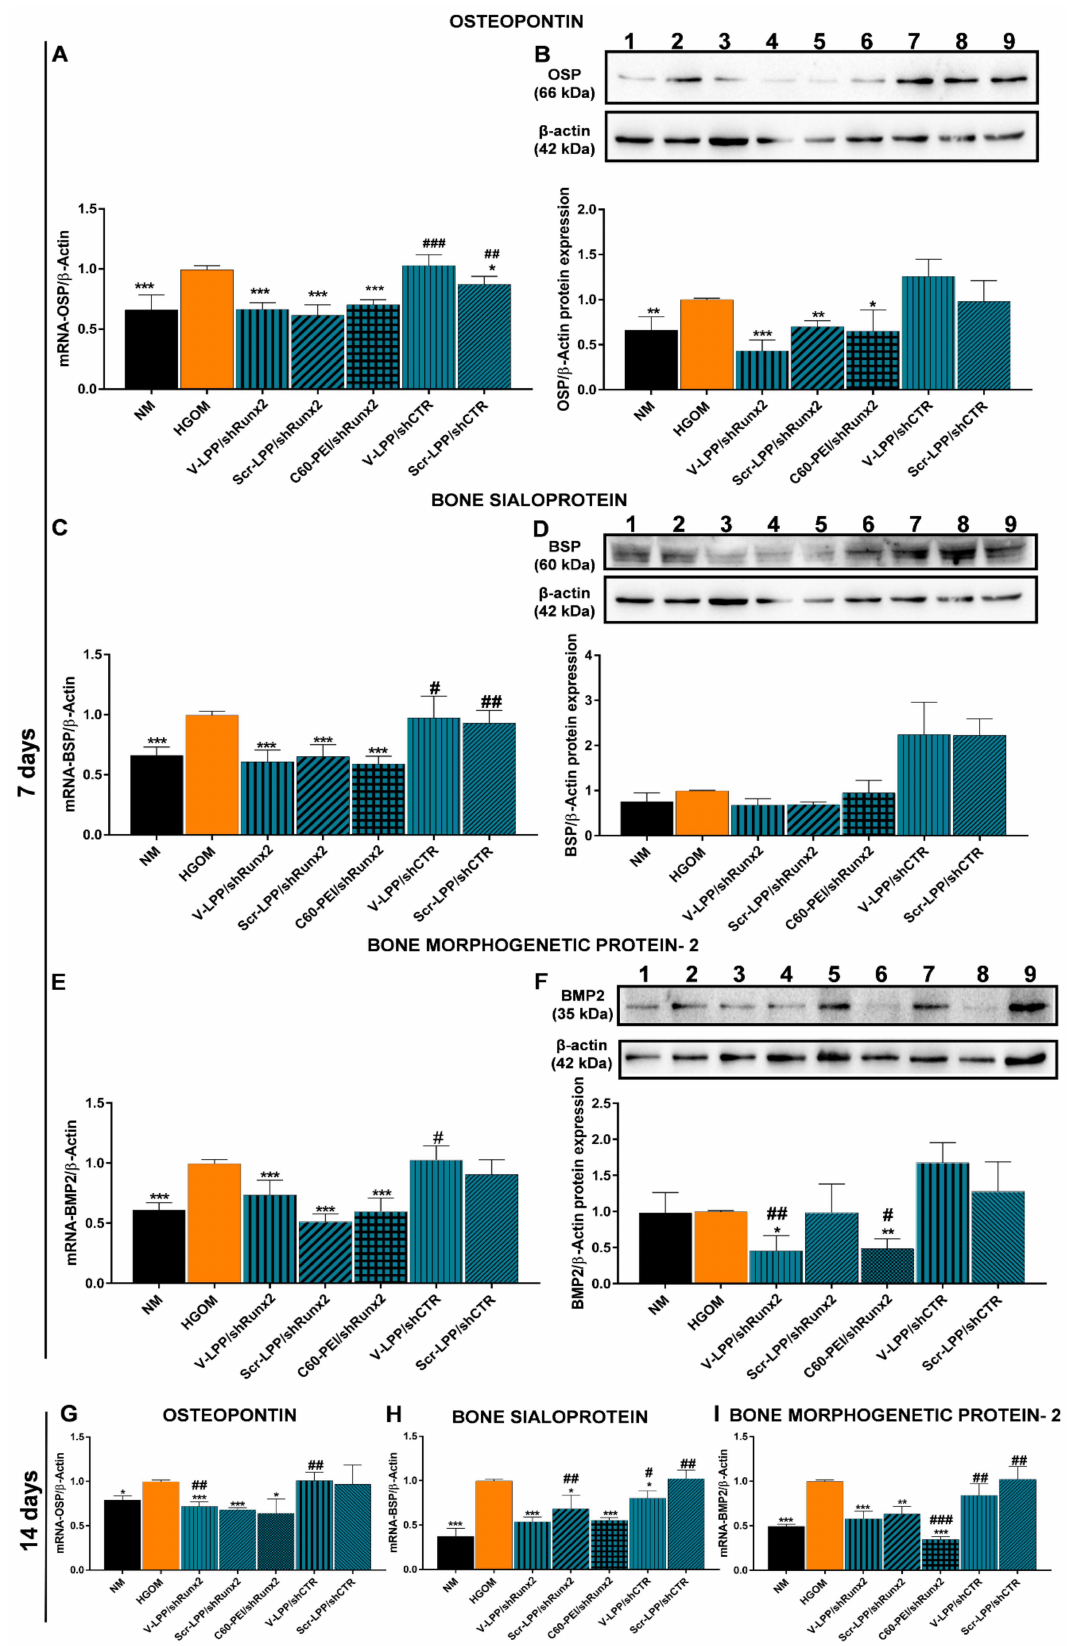
Figure 6. ( A – F ). The reduction of mRNA and protein expression of osteogenic molecules, OSP ( A , B ), BSP ( C , D ), and BMP-2 ( E , F ) in VIC exposed to HGOM for 7 days and transfected with a different